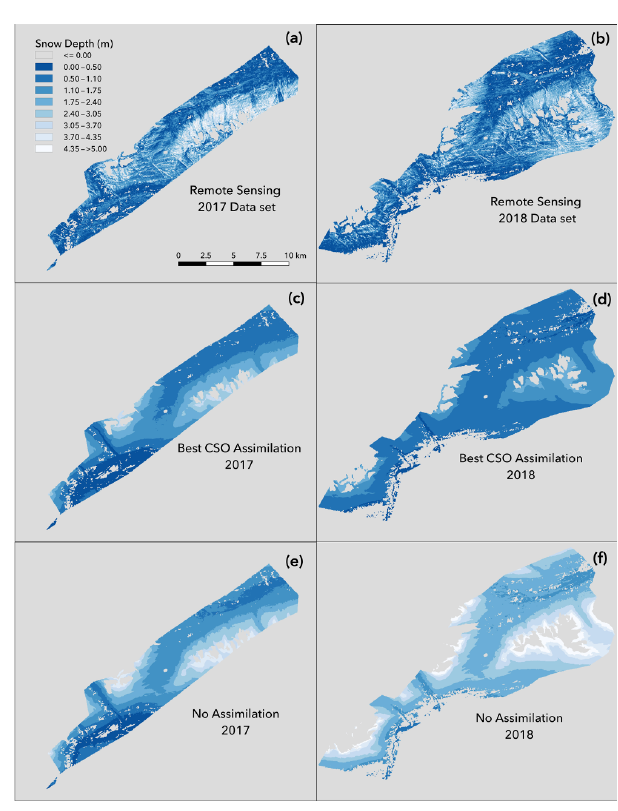
Figure 7. Snow depth distribution maps. (a, b) The remote sensing (RS) data sets from 2017 and 2018. (c, d) The best CSO simulation results corresponding to the RS data set spatial extent. (e, f) The no assimilation results corresponding to the RS data set spatial extent. The total model area that corresponds to the RS data set in 2017 is 104km 2 , and in 2018 it is 149km 2